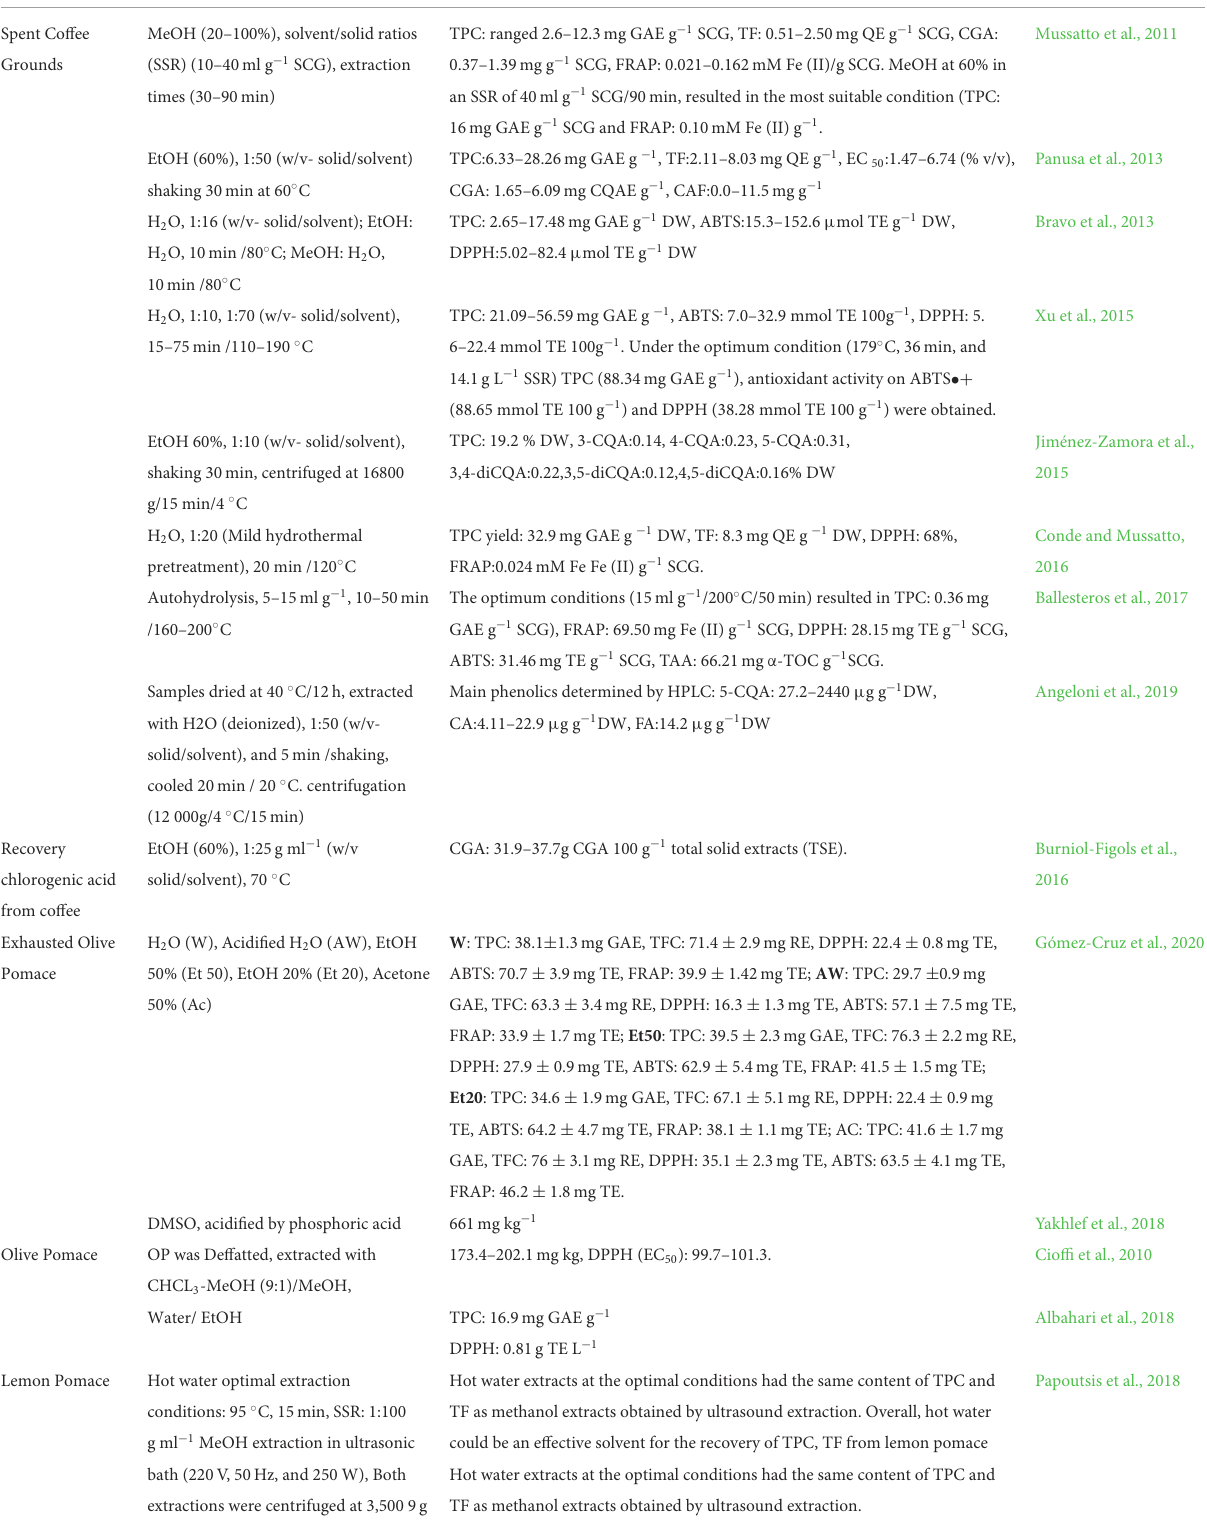
TABLE 2 Conventional extraction of phenolic compounds. Matrix Solvent/performance Extraction yield